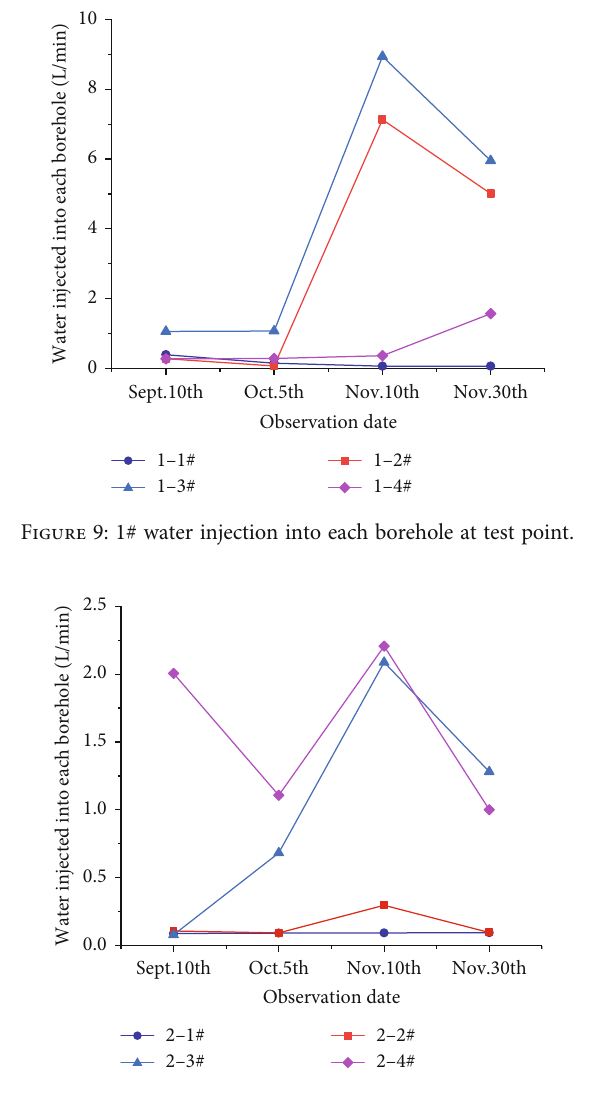
Figure 10: Water injection test results of 1#